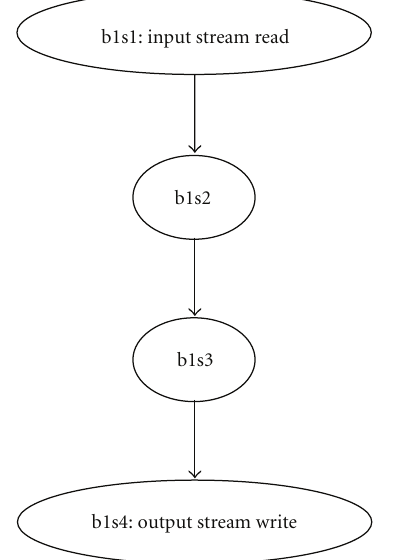
Figure 2: Application’s state machine without assertion.